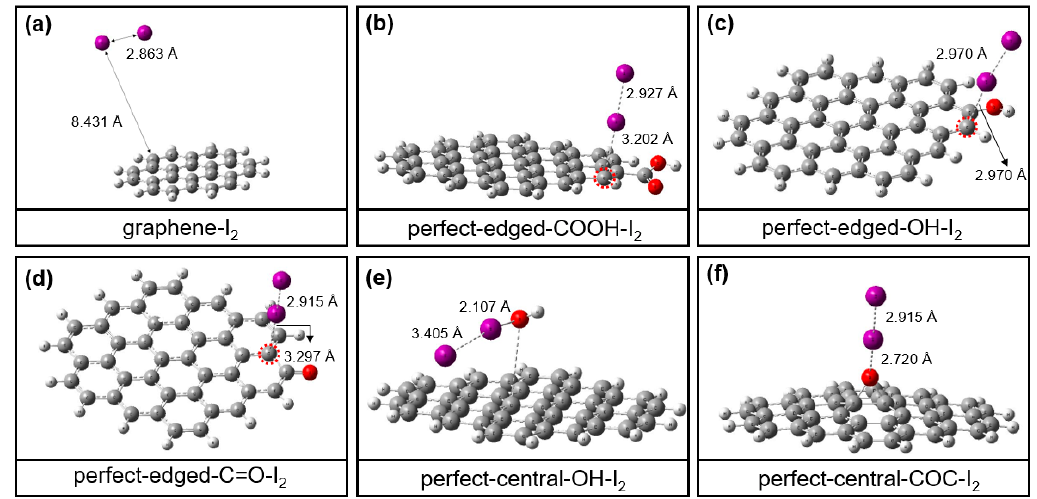
Figure 6. B3LYP functional-optimized structures for ( a ) graphene-I 2 (C 24 H 12 -I 2 ), ( b ) perfect-edged-COOH-I 2 , ( c ) perfect-edged-OH-I 2 , ( d ) perfect-edged-C=O-I 2 , ( e ) perfect-central-OH-I 2 and ( f ) perfect-central-COC-I 2 systems.